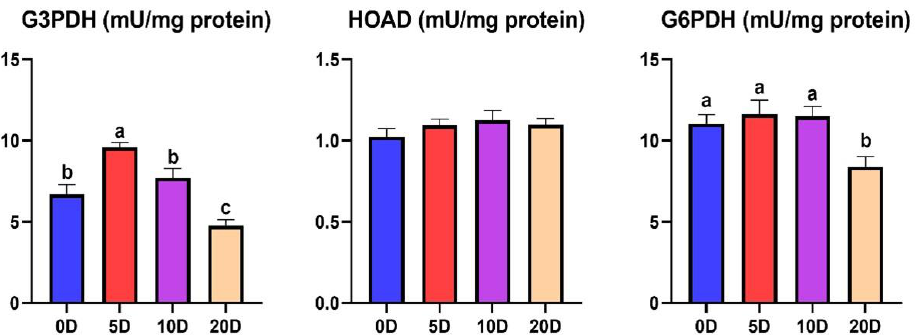
Figure 7. Means ± SEM of enzyme activities ( n = 18 per treatment) related to lipid metabolism in the liver. a, b, c Different letters indicate significant differences between the pre-slaughter times ( p < 0.05). G3PDH: glyceraldehyde-3-phosphate dehydrogenase; HOAD: β -hydroxyacyl CoA dehydrogenase; G6PDH: glucose 6-phosphate dehydrogenase.